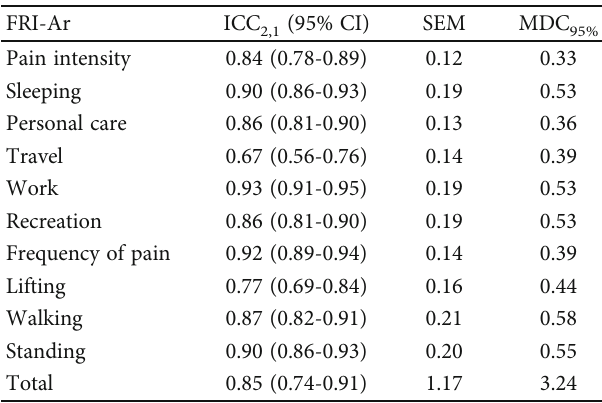
Table 3: Reliability of the